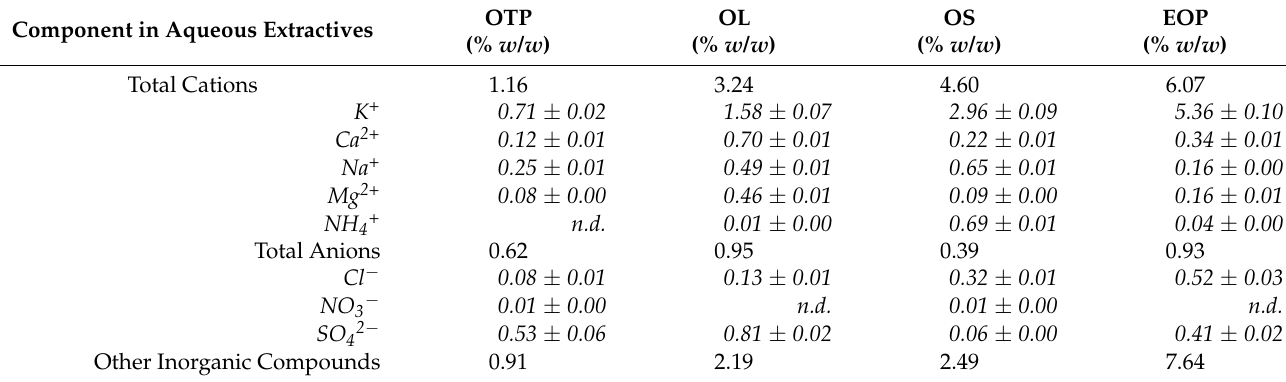
Table 4. Presence of water-extracted inorganic compounds for each olive by-product (% w/w of aqueous extractives). Component in Aqueous